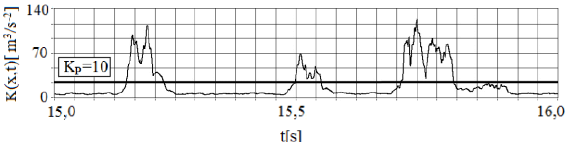
Fig. 5. Criterion function K(t) with threshold C=10, [3]